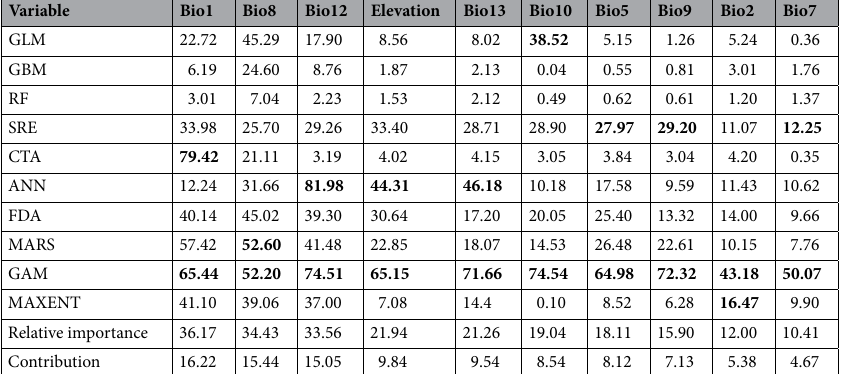
Table 2. Importance (%) of the environmental layers in S. inflata distribution algorithms. The bold variables show the two maximum relative contributions to each model in predicting suitable habitats for this species. The variable relative importance score showed mean variable relative importance in all ten algorithms. The contribution of each environmental variable is the relative percentage of that variable’s relative importance compared to others variables. See other abbreviations as in Table 1 and Fig. 3.